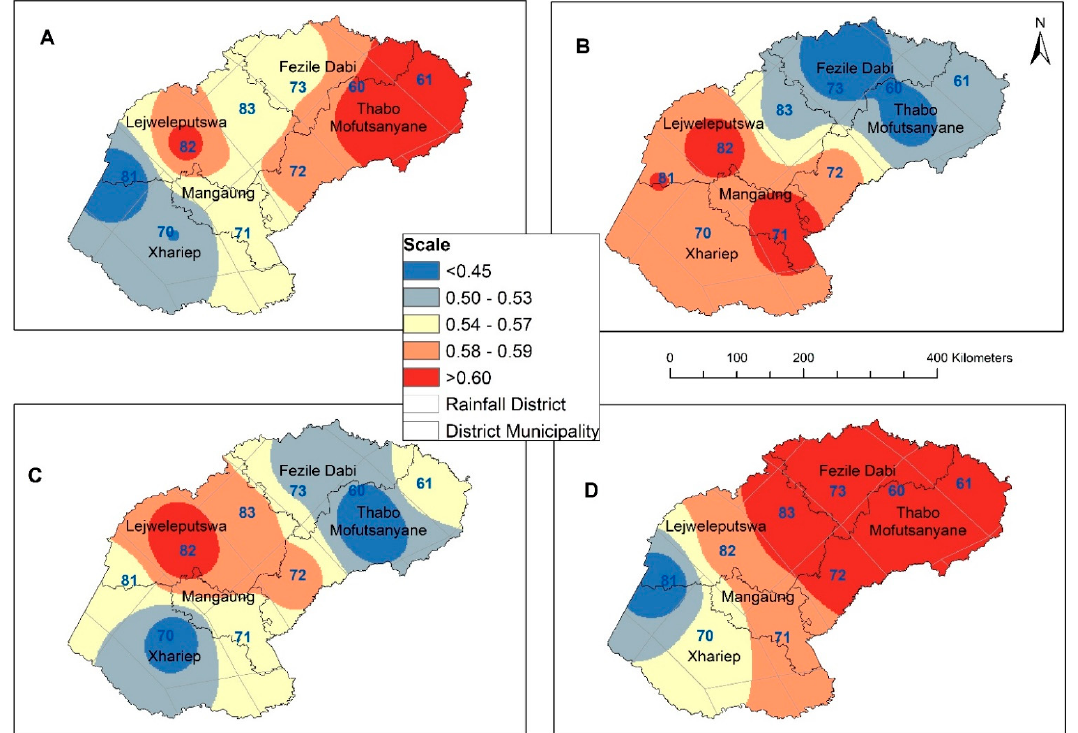
Figure 6. The distribution of scale parameter values of extremes over the Free State Province from 1980 to 2019: ( A ) EDI; ( B ) SPI-3; ( C ) SPI-6; ( D ) SPI-12 . The shape parameter values of the EDI and the SPIs across the selected accumulation timesteps are shown in Figure 7. The shape parameter values range between − 0.01 and 0.33 across the rainfall districts. A negative distribution of the shape parameter values is observed for the EDI in Dis60, -61, -72, -73, and -82 (Figure 7A); also, for SPI-6 in Dis60, - 61, -71, -72, -73, -82, and -83 (Figure 7B); and for SPI-12 in Dis60, -61, -70, -71, -72, -73, -82, and -83 (Figure 7C). Given the shape parameter values, Type III (Weibull) of the GEV distribution best describes the EDI and SPI index extremes for the districts. Furthermore, a positive distribution of shape parameter values is detected for the EDI in Dis70, -71, and -81, also for SPI-6 in Dis70 and -81, and for SPI-12 in Dis81. The Type II (Fréchet) extreme value distribution best describes the drought indices for these districts. There is a slight difference in the SPI-3 shape parameter values, as a negative distribution of shape param- eter values is detected across the rainfall districts, i.e., − 0.25 to − 0.02. According to the shape parameter values, Type III (Weibull) of the GEV distribution best describes the ex- tremes of the SPI-3 values for all districts. Furthermore, 45% of the distribution of EDI shape parameter values and 55% of the distribution of SPI-12 shape parameter values in the Free State Province are less than − 0.09. Approximately 30% of the distribution of the SPI-6 shape parameter values in the Free State Province range from − 0.10 to 0.05.